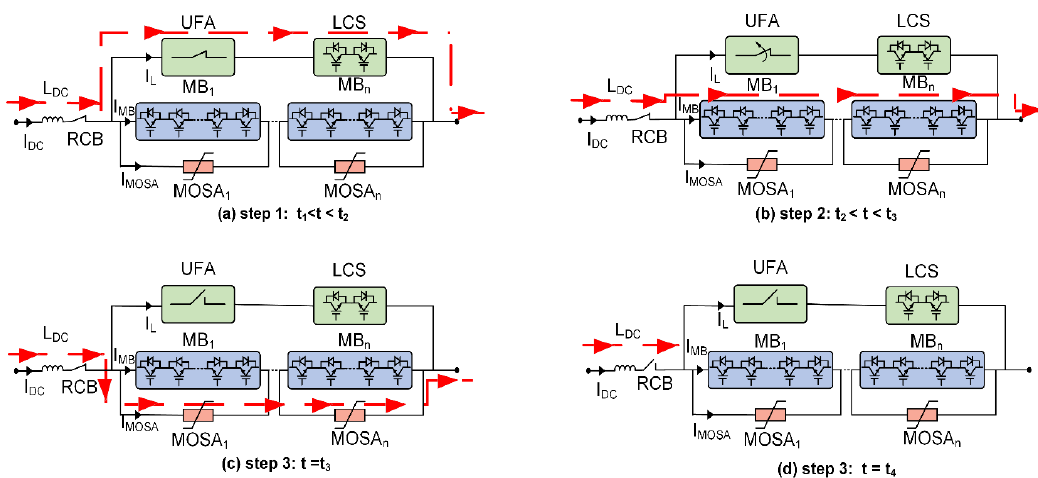
Figure 4. H-DCCB fault current interruption sequence.